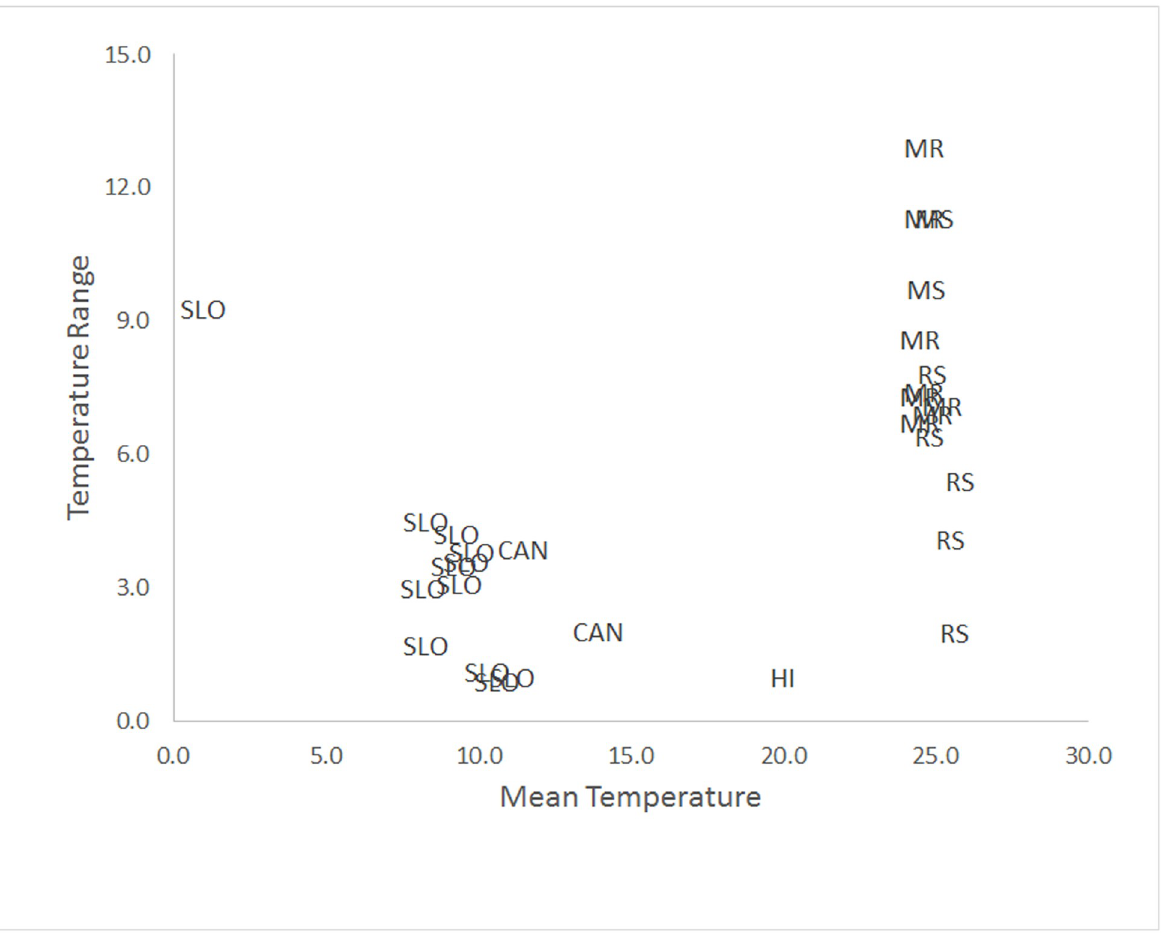
Fig 11. Comparison of overall temperature variability in caves for which year long hourly temperature records are available. Abbreviations are SLO (Slovenia), CAN (Canary Islands), HI (Hawaii), MR (Mue´velo Rico), MS (Mue´velo Sobrosito), and RS (Rio Secreto [Tuch]). Data from present study and [14, 16, 19,